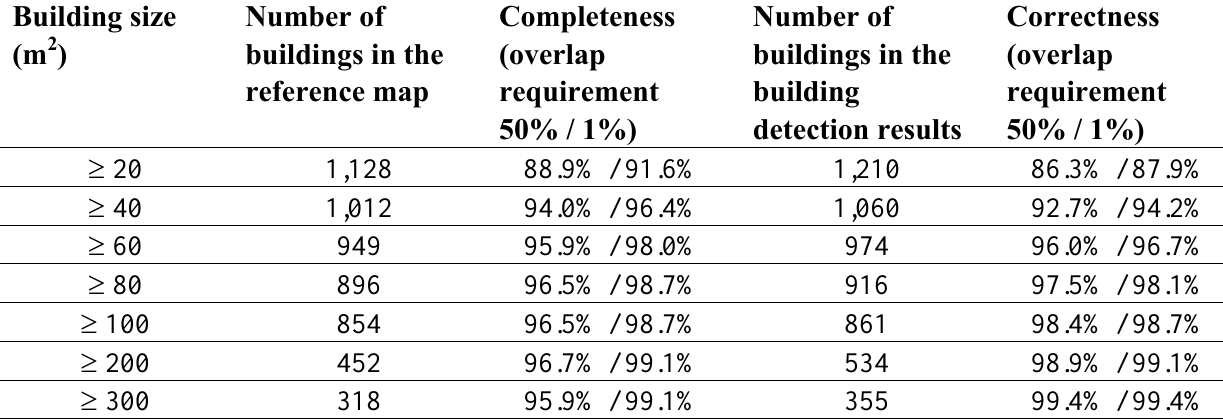
Table 3. Building-based accuracy estimates for the building detection results. All test areas included. An overlap of either 50% or 1% between reference and detected buildings was required to consider a building correctly